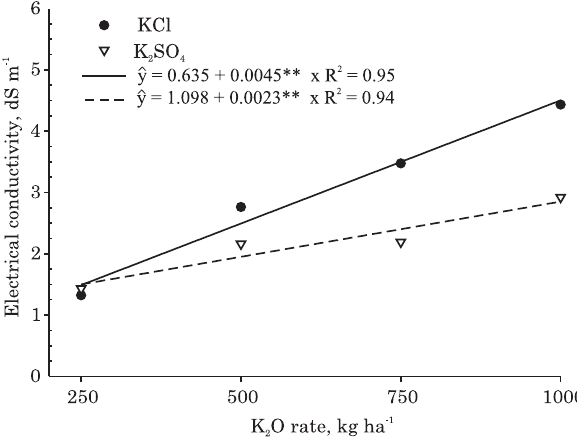
Figure 1. Effect of K sources and rates on soil electrical conductivity.